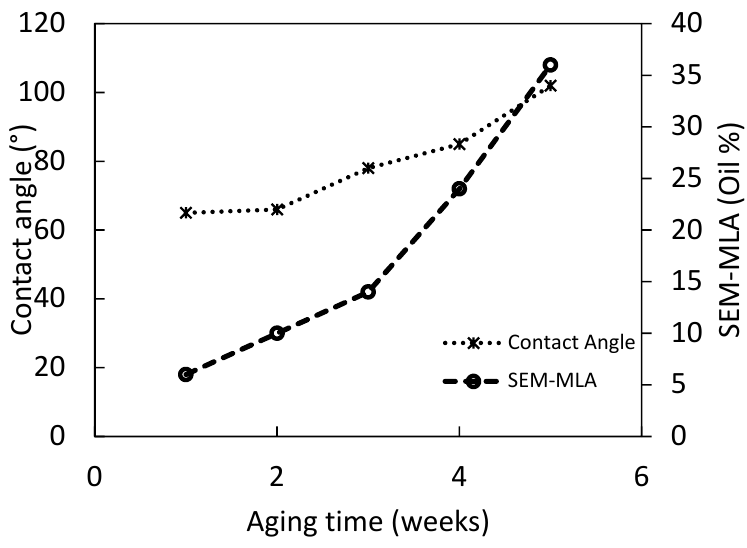
Figure 6. Comparison of contact angle data and SEM-MLA data for